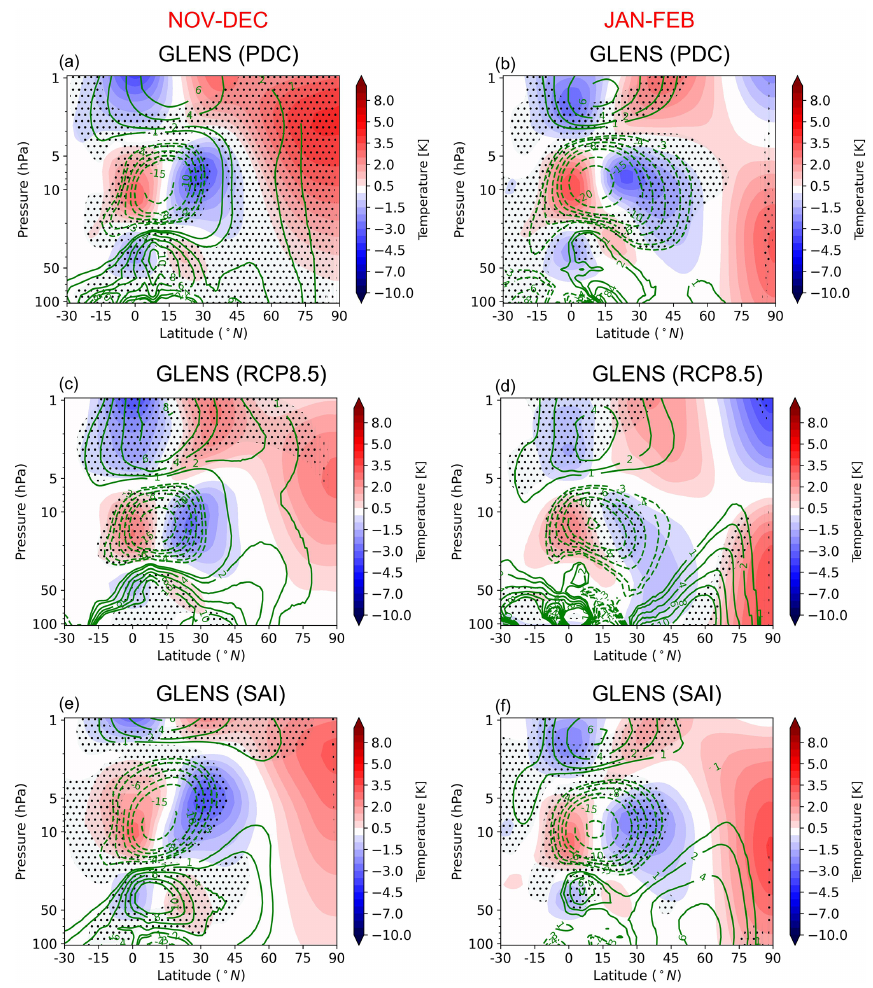
Figure 9. Latitude–pressure cross section of the QBO composite differences (QBOe–QBOw) of the zonal mean meridional stream lines (green contours) and temperature (color shaded). The streamlines are calculated based on Eq. (7), and hence the contributions from both Rossby and gravity waves are included. The stippled areas indicate regions where the changes in the zonal mean meridional stream lines are statistically significant at the 95% level according to the t